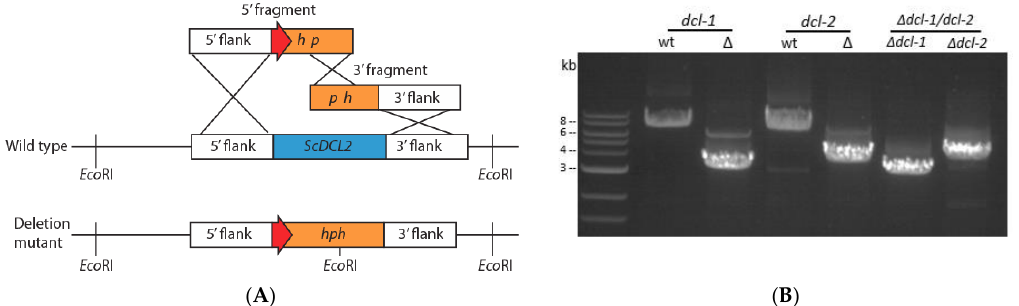
Figure 1. ( A ) Generation of deletion mutants for dicer genes in S. sclerotiorum using the split-marker gene replacement method (orange: selective marker, ex. hph ; blue: gene replaced, ex. dcl - 2 ; red: TrpC promoter) and ( B ) electrophoresis gel image of PCR amplification to confirm dicer gene disruption using F1–F4 primer pairs. Amplicons of wild-type dcl-1 and dcl-2 genes (7.7 kb and 7 kb, respectively) and deletion alleles (3.3 and 3.9 kb) differ in size. Lanes 5 and 6 show deletion alleles (3.1 and 3.9 kb) in the double dicer mutant.